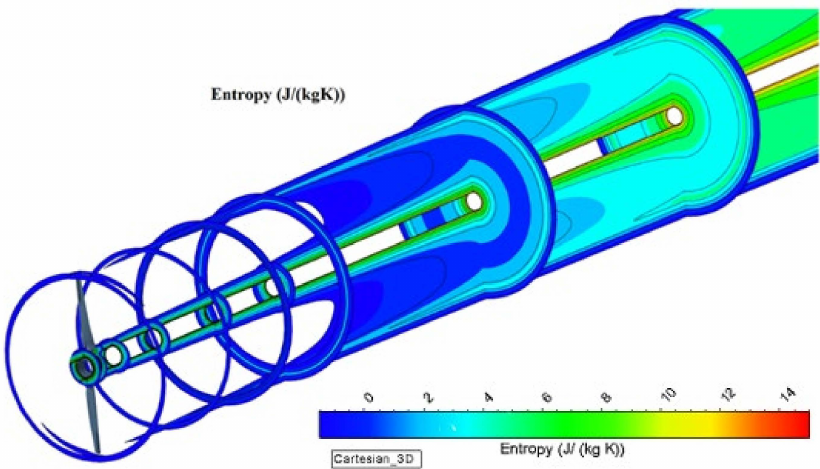
Figure 37. Induced drag per area downstream of the wind turbine rotor for 4X domain.